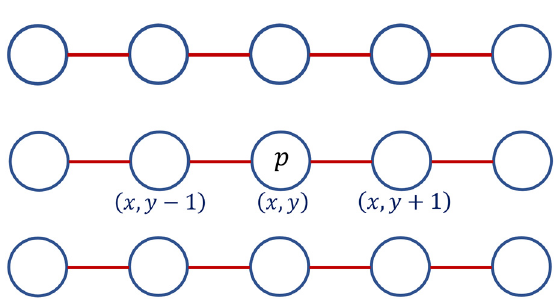
Figure 1. A pixel located at p and its two horizontal neighbors, denoted as N h ( x , y ) . In minimizing each of the objective function H x , we may take partial derivative of it (cid:48) ( x , y , d ) with respect to C